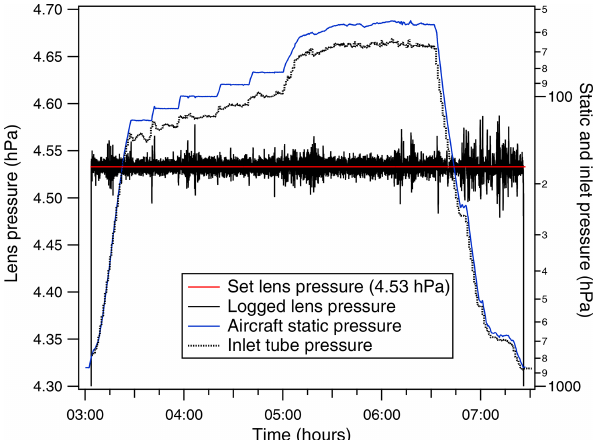
Figure 4. Stable CPI operation in the ERICA instrument is demon- strated by the recorded lens pressure aboard the M-55 Geophysica aircraft (StratoClim Project, flight on 27 August 2017). The maxi- mum deviation of the lens pressure from the set value is 1.2%. The flight was chosen for its high maximum altitude (GPS) of 20.45km with a minimum inlet pressure of 64hPa and ambient pressure of 55hPa (the difference is caused by the dynamic pressure). Time is